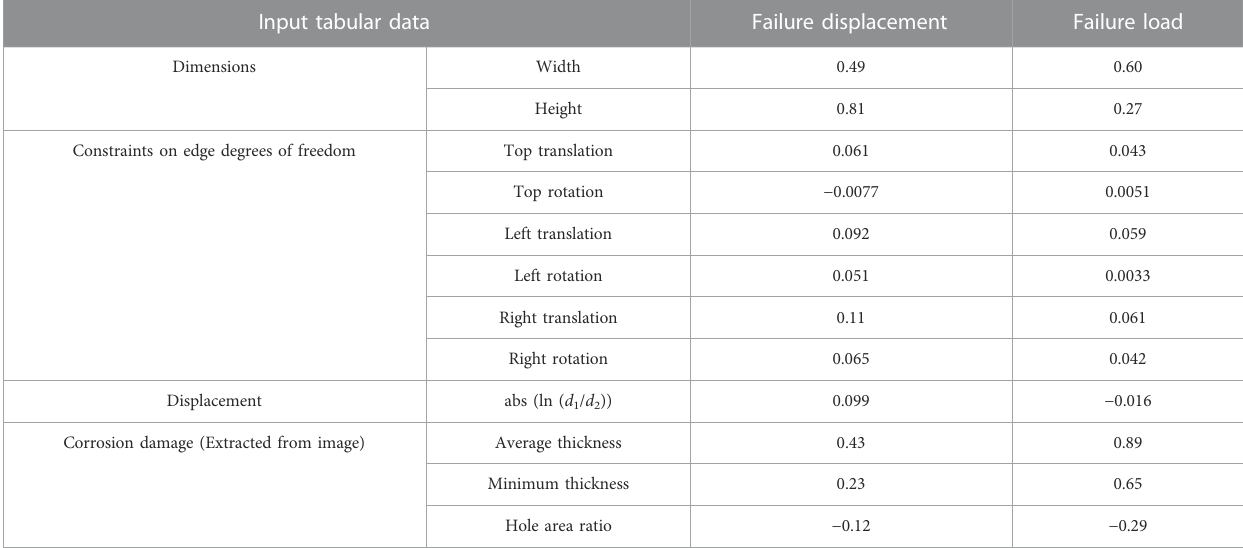
TABLE 4 Correlation between the tabular data and the failure load and displacement